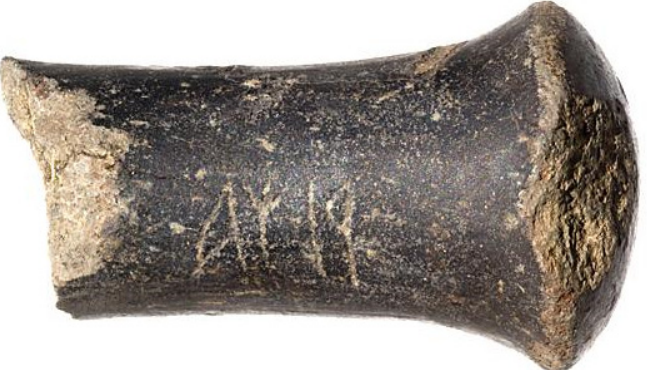
Figure 13. Orientalizing impasto rocchetto fragment with RIXA inscription, 675/650–600 BCE (Image: Poggio Civitate Project).